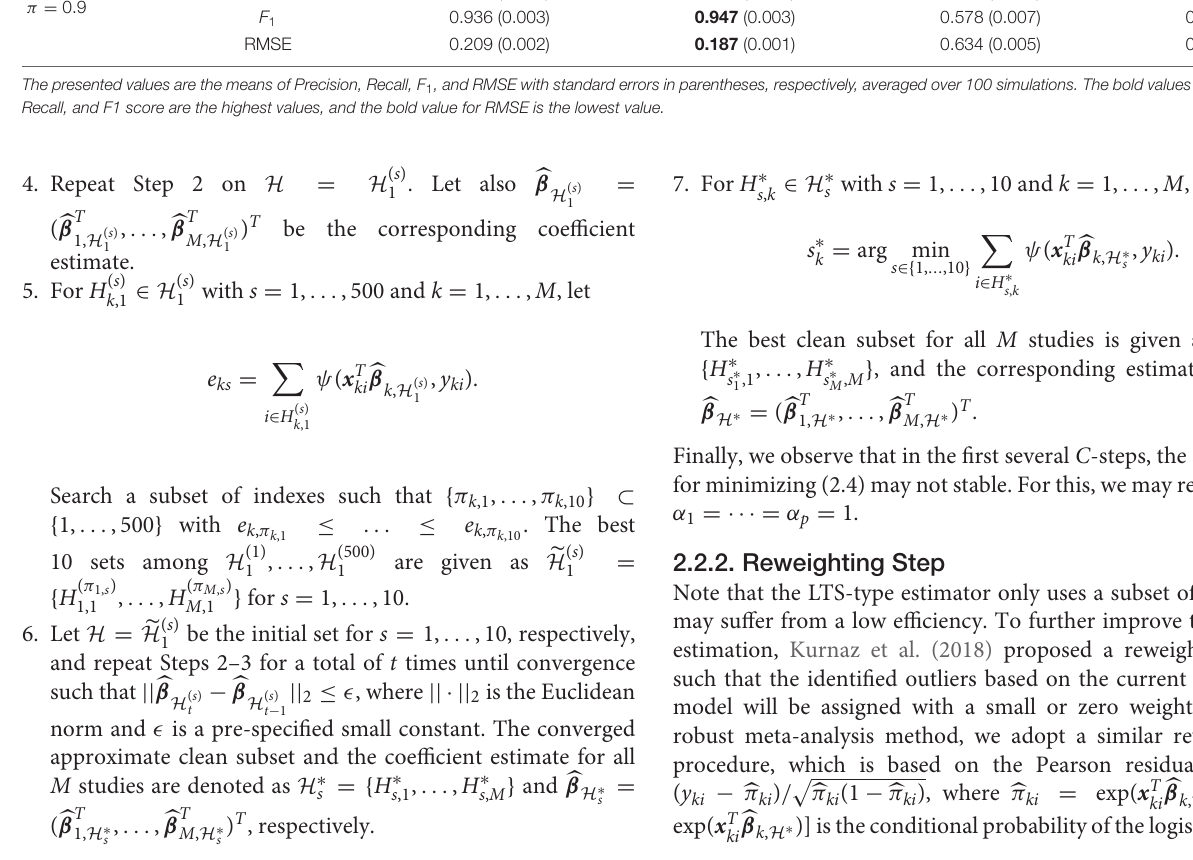
TABLE 1 | Results for low-dimensional data with clean data. M =